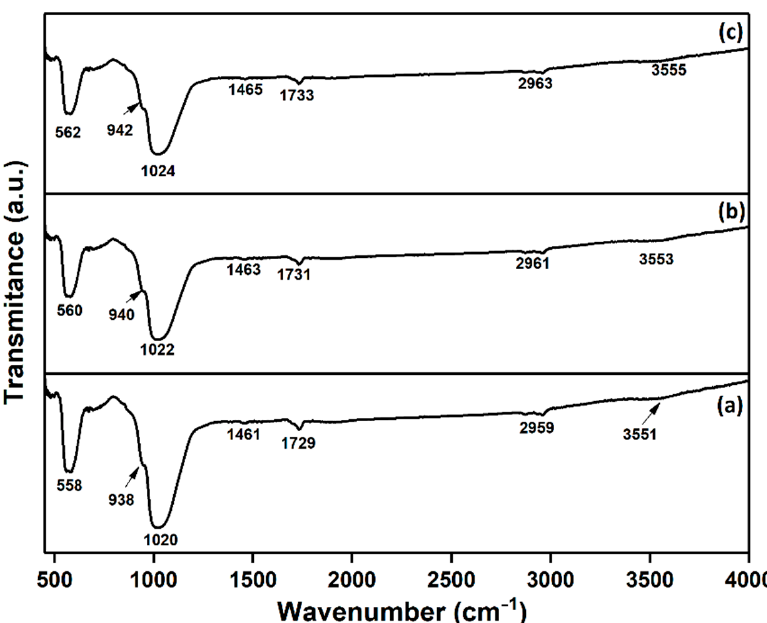
Figure 1. FT-IR spectra of CS–HAp coatings at: ( a ) p = 2 × 10 − 3 mbar; ( b ) p = 5 × 10 − 3 mbar; ( c ) p = 1.2 × 10 − 2 mbar.